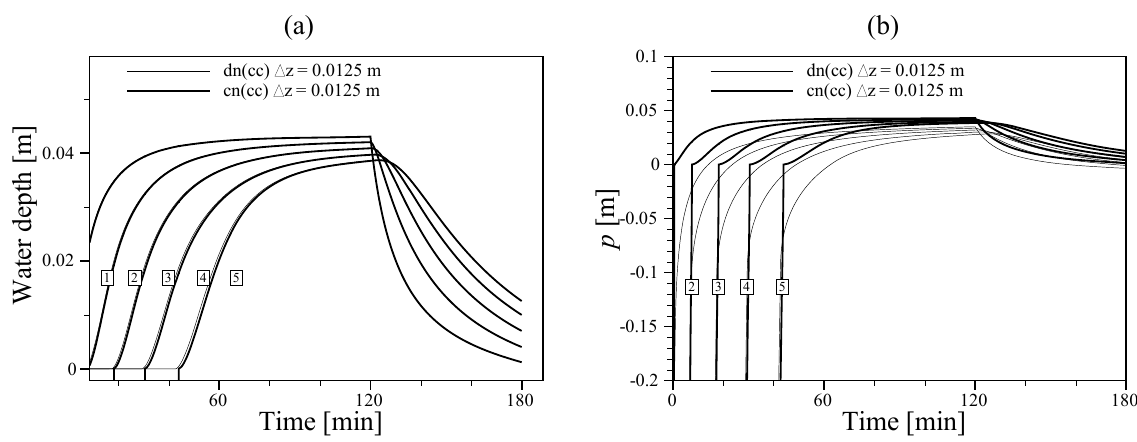
Figure 12. Simulated values for excess infiltration (third scenario) on a hillslope with a cell-centered scheme and (cid:49)z = 0.0125m. (a) Water depths at the surface nodes. (b) Pressure heads at the topmost subsurface nodes. Nodes are numbered 1–5 in the downslope